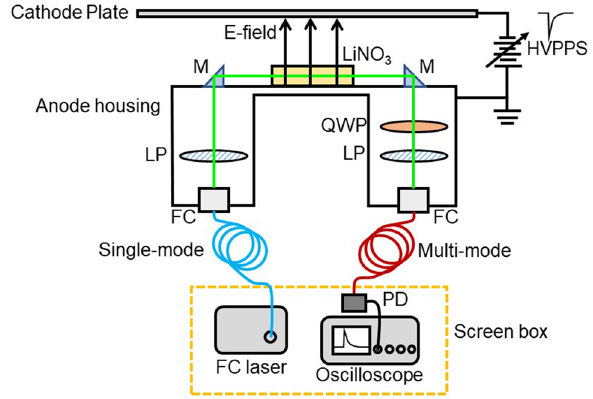
Figure 1. A schematic diagram and picture of the EOS benchtop laboratory setup including the 532 nm fiber coupled laser, high pulsed power supply (HVPPS) connected to the cathode plate and EOS anode housing, fiber